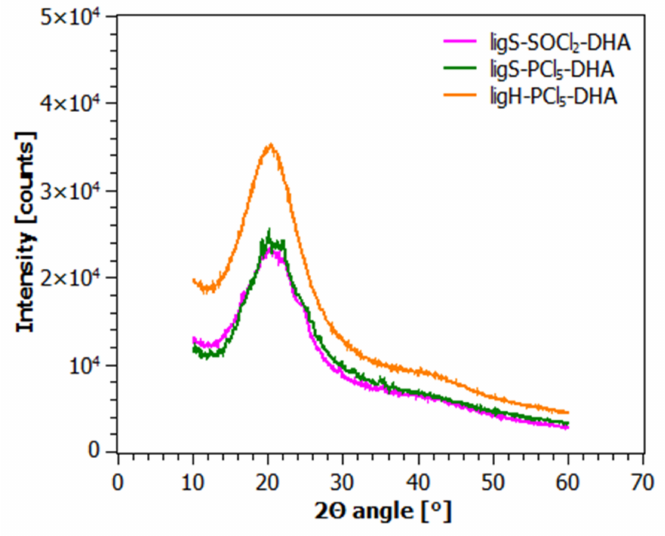
Figure 5. Diffraction patterns of the materials after the second step of